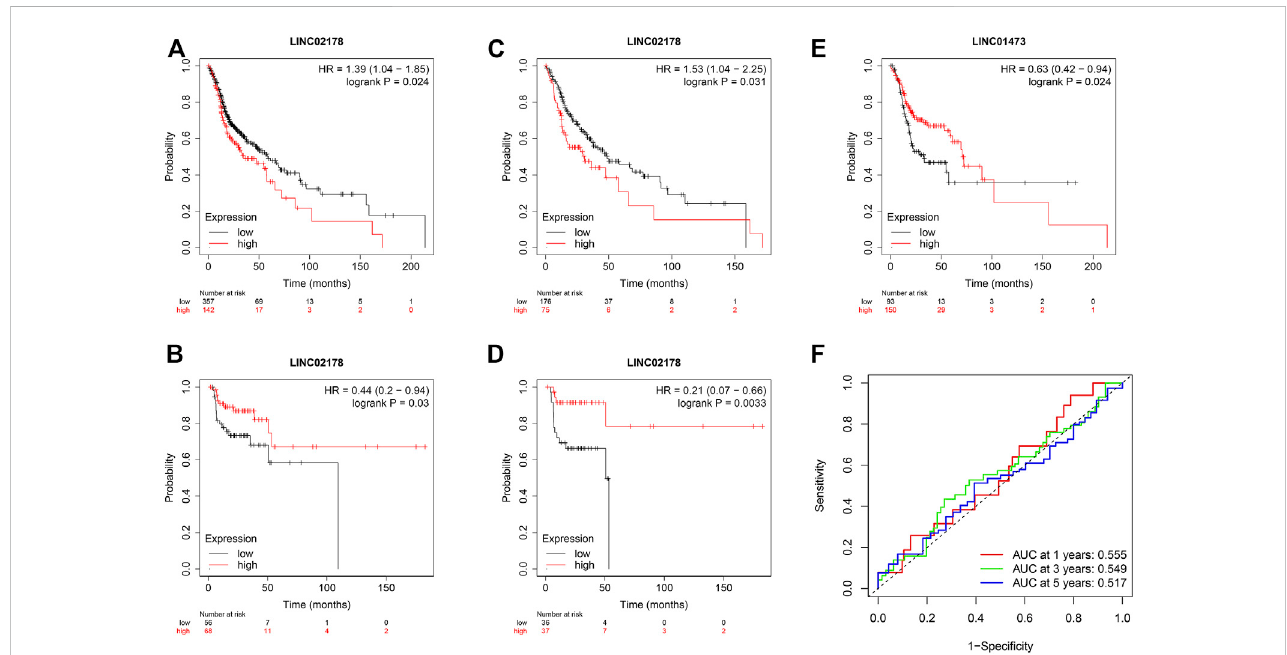
FIGURE 10 (A – E) Prognostic value of LINC02178 and LINC01473 based on Kaplan – Meier plotter. (A) Kaplan-Meier curve to show OS of patients in different LINC02178 expression levels. (B) Kaplan-Meier curve to show RFS of patients in different LINC02178 expression levels. (C) Kaplan-Meier curve to show OS of patients with high-TMB in different LINC02178 expression levels. (D) Kaplan-Meier curve to show RFS of patients with low-TMB in different LINC02178expressionlevels. (E) Kaplan-Meiercurvetoshow OSofpatientswith low-TMBindifferentLINC01473expressionlevels. (F) Prognostic value of CRLs based on TCGA-CESC.